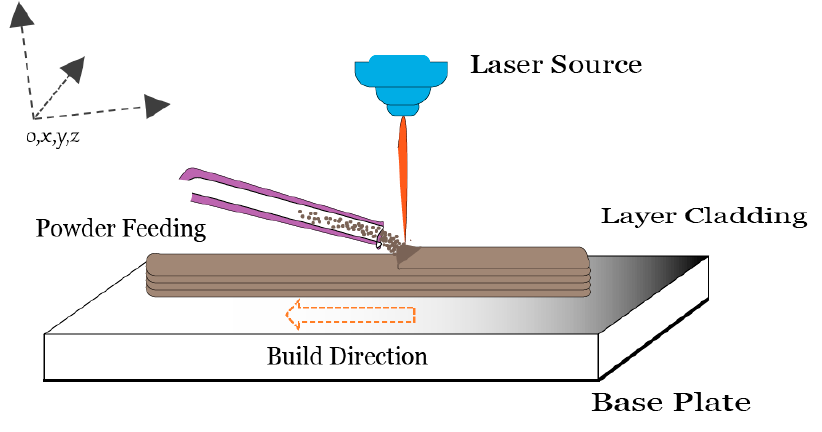
Figure 1. Powder-fed laser cladding process schematic.